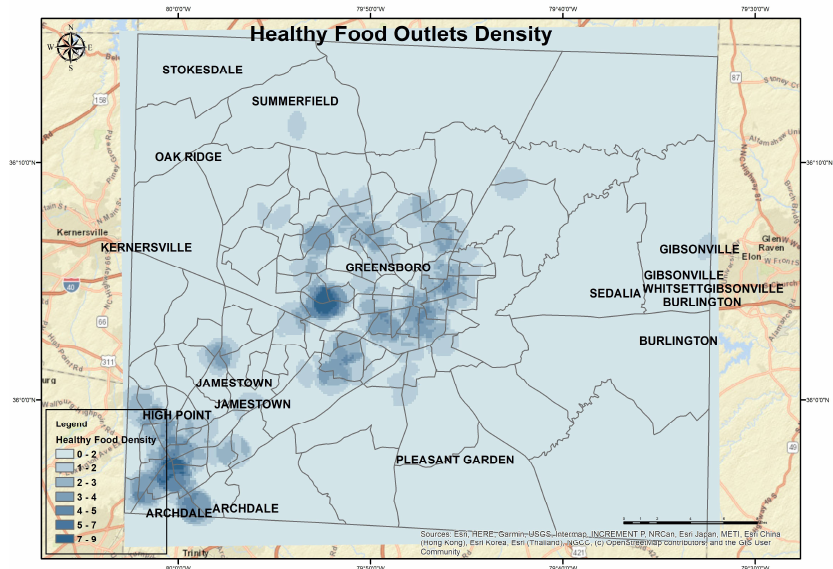
Figure 6. Geospatial map showing the density of healthy food options. Figure 6. .